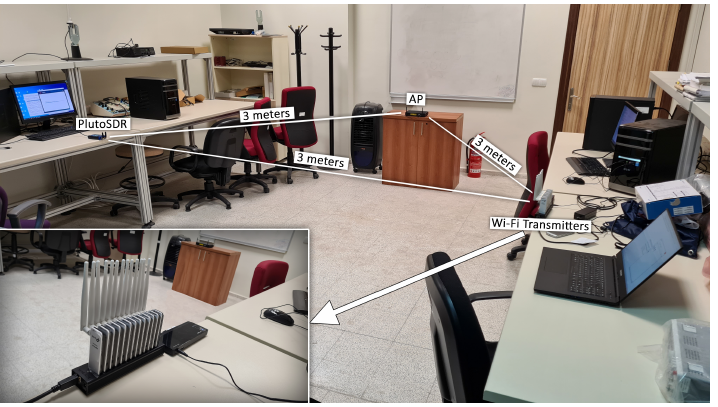
Figure 9. Experimental setup for data acquisition.